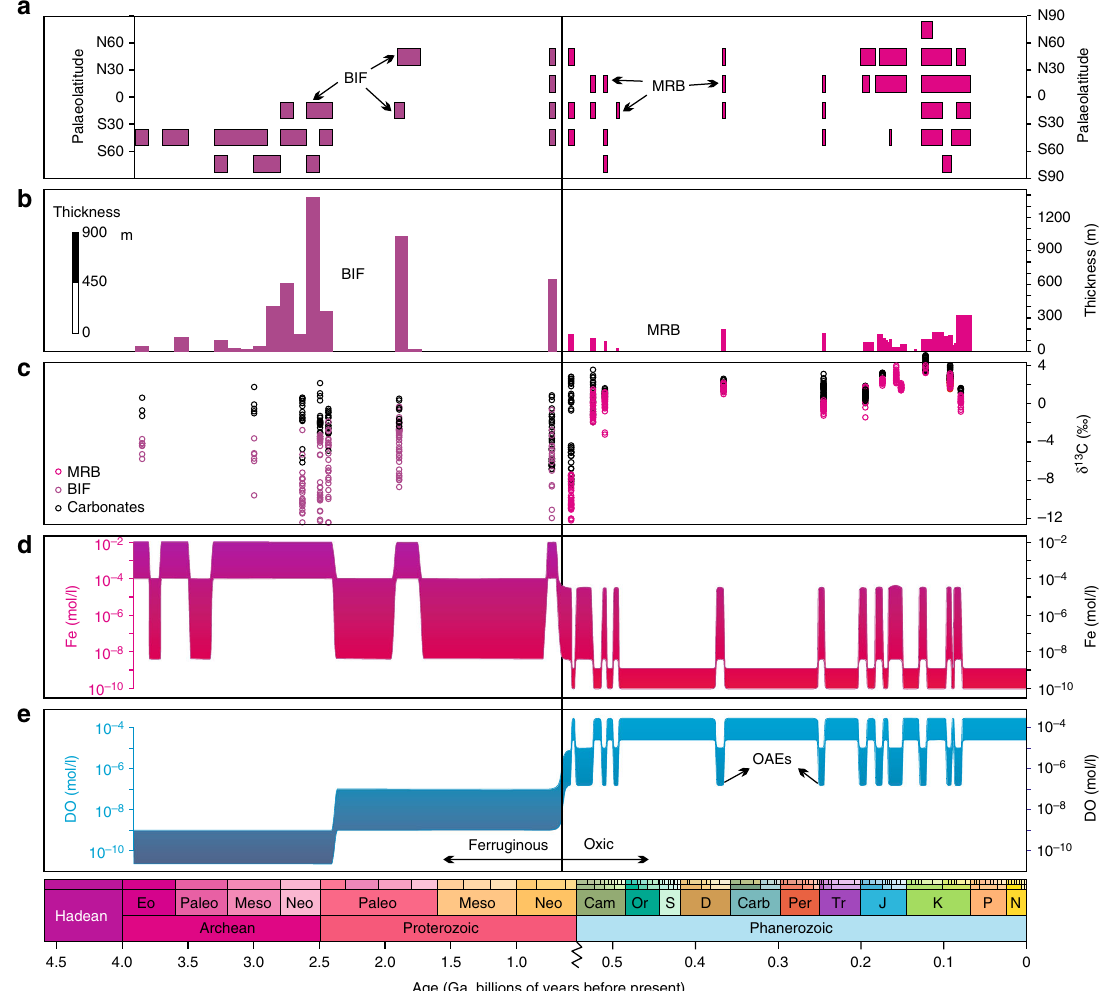
Fig. 2 Secular distributions and carbon isotopes of Fe-related rocks and the evolution of marine redox and iron states. a Palaeolatitudinal distribution of banded iron formations (BIFs) and marine red beds (MRBs). The data are compiled from Supplementary Table 2. Note that the palaeolatitude data are at a lower con fi dence level for Archean and early Proterozoic interval. b Temporal distribution of BIFs and MRBs with thickness information (see data in Supplementary Figs. 1, 2 and Supplementary Table 2). c Carbon isotopes in iron-related sedimentary rocks and adjacent carbonates ( purple circle are the data from banded iron formations, magenta circles are the data from red beds, black circles are the data from adjacent grey carbonates; see data in Fig. 3 and Supplementary Figs. 3 – 7 and Supplementary Tables 1, 3). d Evolution of deep-water (below storm wave base) iron concentrations based on numerical model (Fig. 4) and modern analogues. The lower limit of iron concentrations for BIF and MRB are 50 μ M and 4 nM, respectively (see discussion in text). e Evolution of deep ocean (below storm wave base) redox states in the Phanerozoic and Precambrian (after refs 9, 57